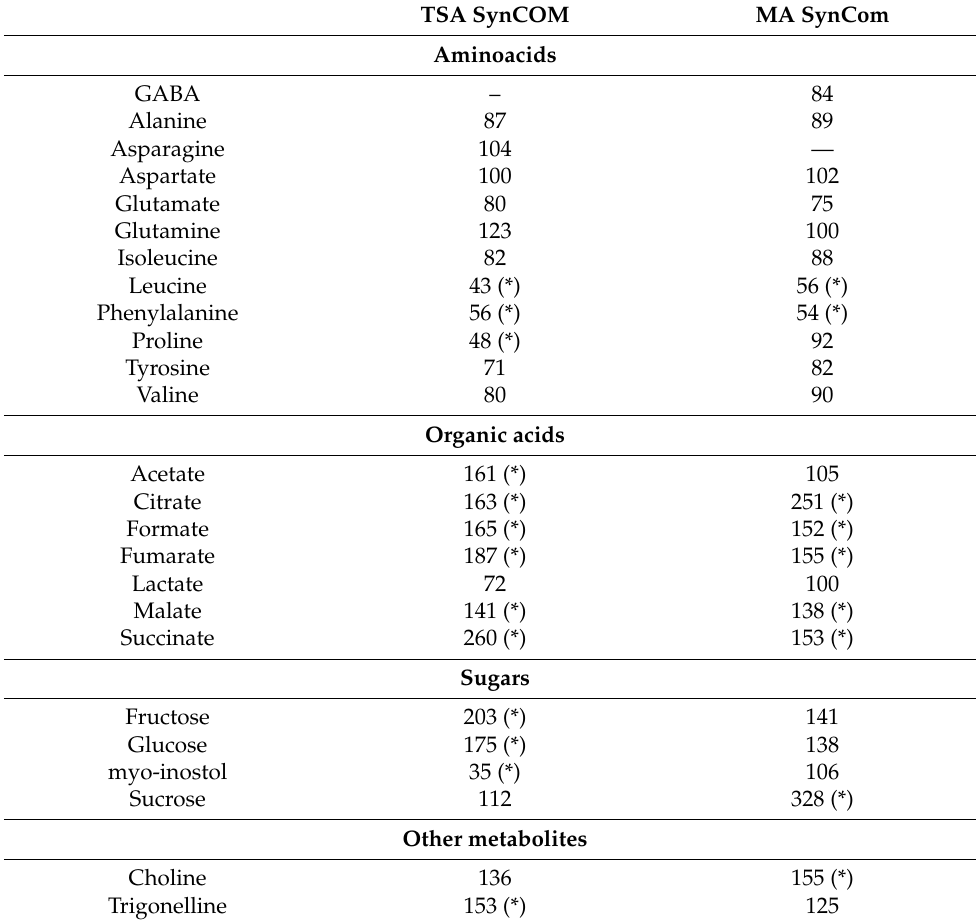
Table 5. Effect of inoculation with TSA or MA SynComs on the concentration of metabolites of M. crystallinum plants cultivated in the presence of a mixture of metals/metalloids (10 µ M As + 1 µ M Cd + 20 µ M Cu + 50 µ M Zn). Data represent the percentages with regard to non-inoculated plants, considered as 100%. Statistically significant differences with regard to the non-inoculated controls are indicated by asterisks. TSA SynCOM MA SynCom Aminoacids